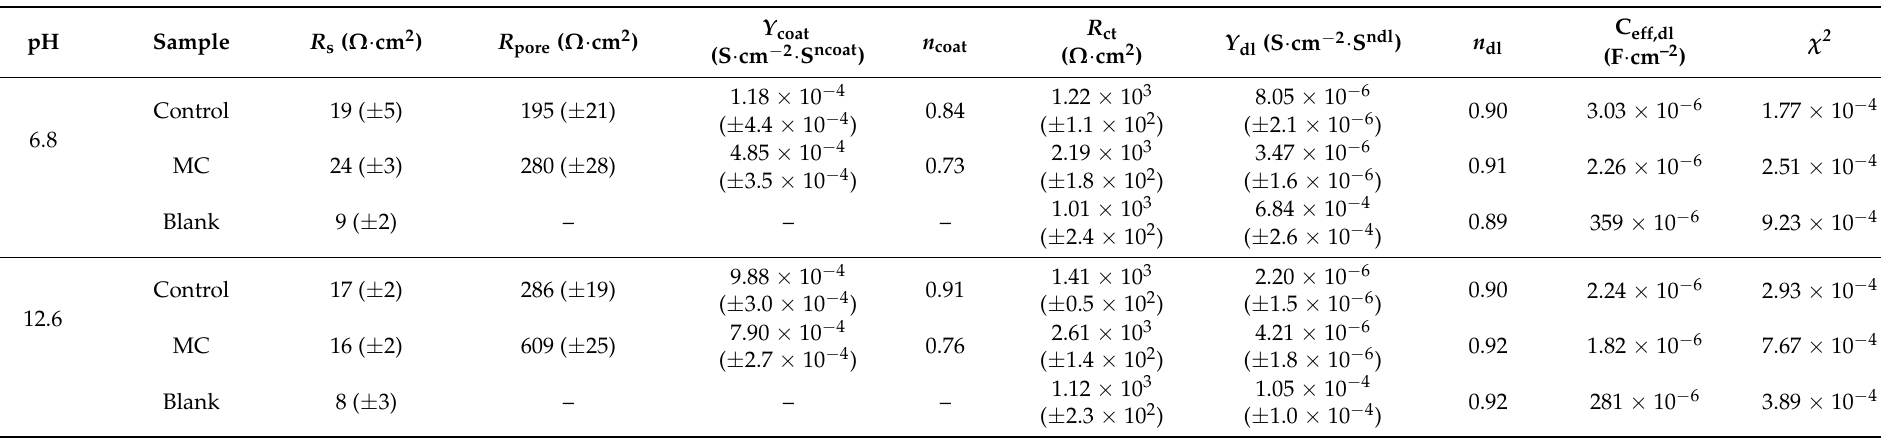
Table 4. EIS fitting values obtained for acrylic coated control steel panels and MC modified acrylic coated panels exposed to 3.5 wt% NaCl contaminated environment in DI water (pH 6.8) and SCPS (pH 12.6) using the equivalent circuit presented in Figure 8. The standard deviation is presented in the